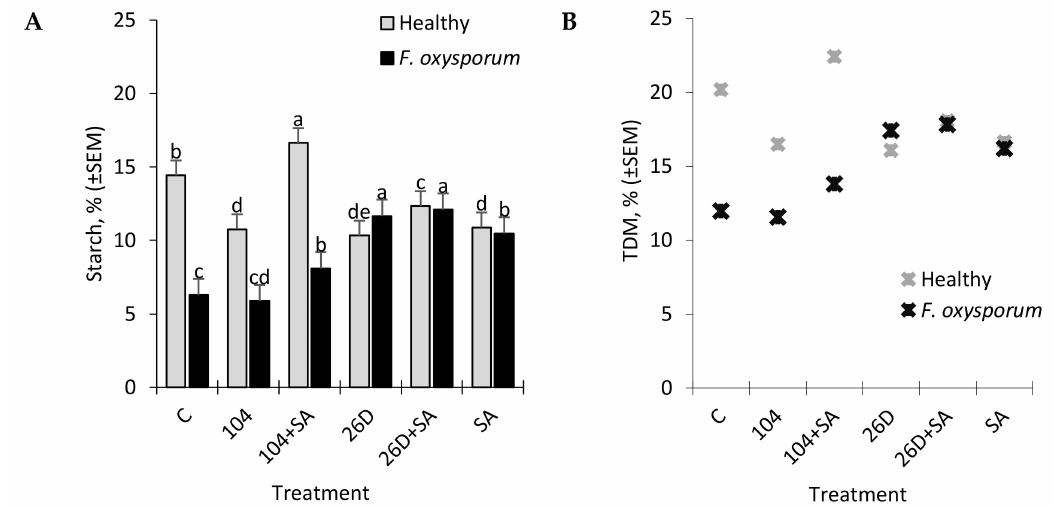
Figure 6. Changes in the contents of starch ( A ) and total dry matter (TDM) ( B ) in non-infected (Healthy) and infected with the phytopathogenic fungus F. oxysporum ( F. oxysporum ) potato tubers under the influence of treatments with B. subtilis 10-4 (104), B. subtilis 10-4 + SA (104 + SA), B. subtilis 26D (26D), and B. subtilis 26D + SA (26D + SA) after six months storage. The bars are the means of three repetitions ± SEM. Different letters indicate a significant difference between the means at the probability level of p <